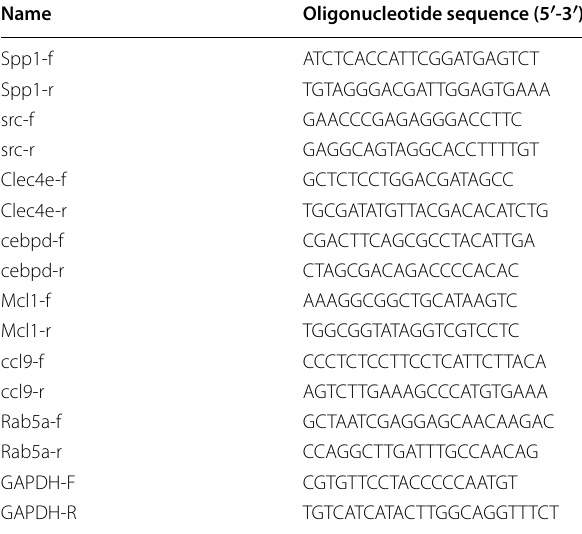
Table 1 Primers used for RT-qPCR